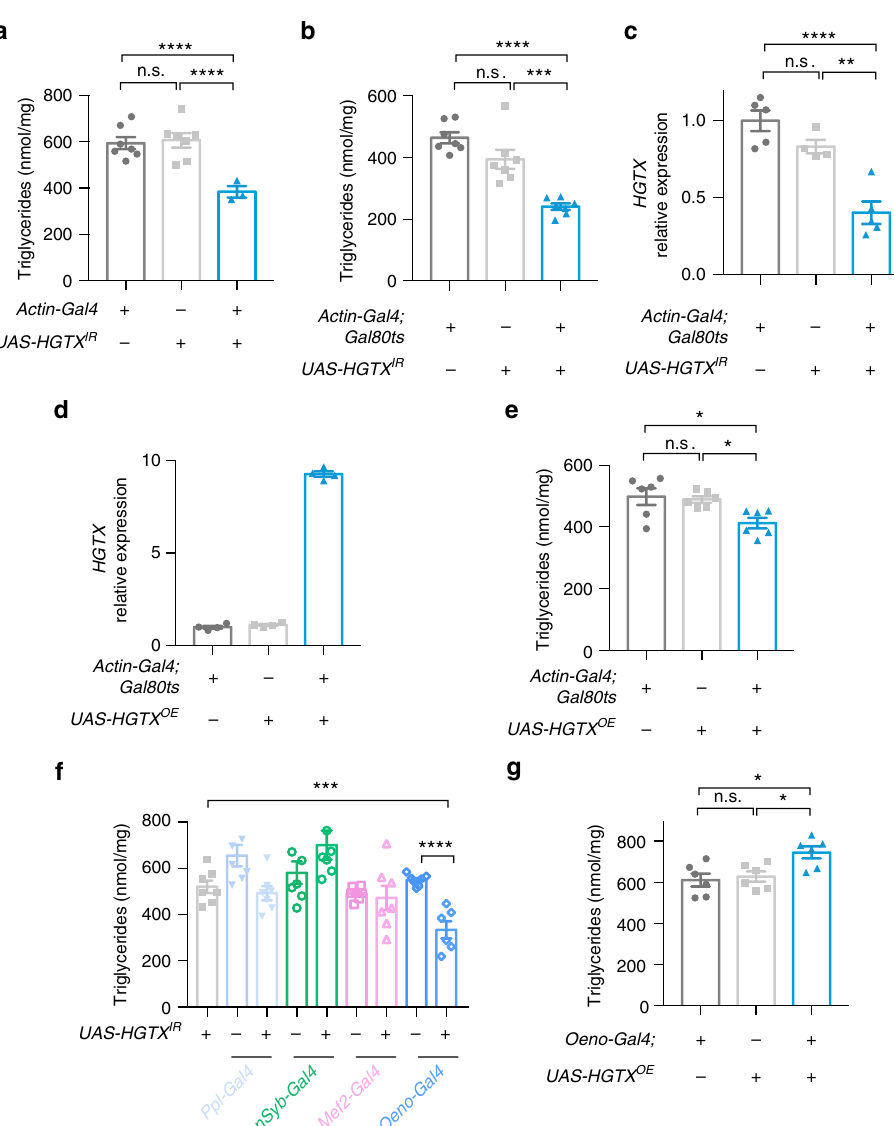
Fig. 4 HGTX/NKX6.3 regulates triglyceride (TAG) in Drosophila . a Whole-body HGTX RNAi decreased TAG level in adult fl ies, n = 4 – 8 groups, 10 fl ies each. b TAG levels in adult inducible of whole-body HGTX RNAi fl ies, n = 7 groups, 5 fl ies each. c HGTX mRNA was signi fi cantly reduced in adult inducible RNAi fl ies, n = 4 – 5 groups, 5 fl ies each. d HGTX mRNA overexpression detected by qPCR, n = 4 groups, 5 fl ies each. e TAG levels in adult inducible whole-body HGTX over-expression fl ies, n = 6 groups, 5 fl ies each. f TAG levels in tissue-speci fi c HGTX RNAi fl ies, n = 6 – 7 groups, 5 fl ies each. g TAG levels